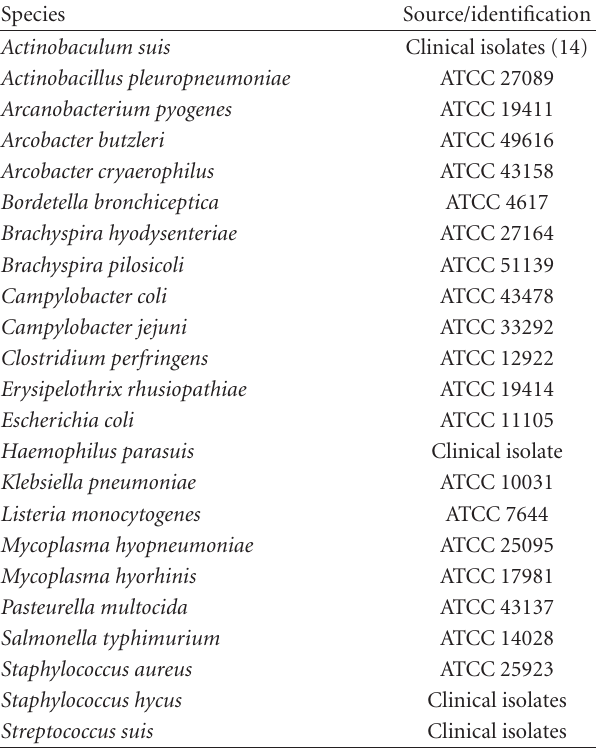
Table 2: Bacteria species used to test analytical specificity of PCR for Actinobaculum suis .